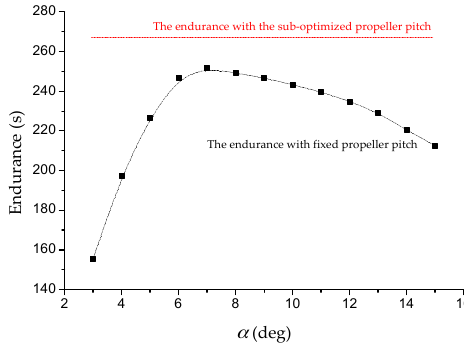
Figure 8. The endurance performance versus propeller pitch angles